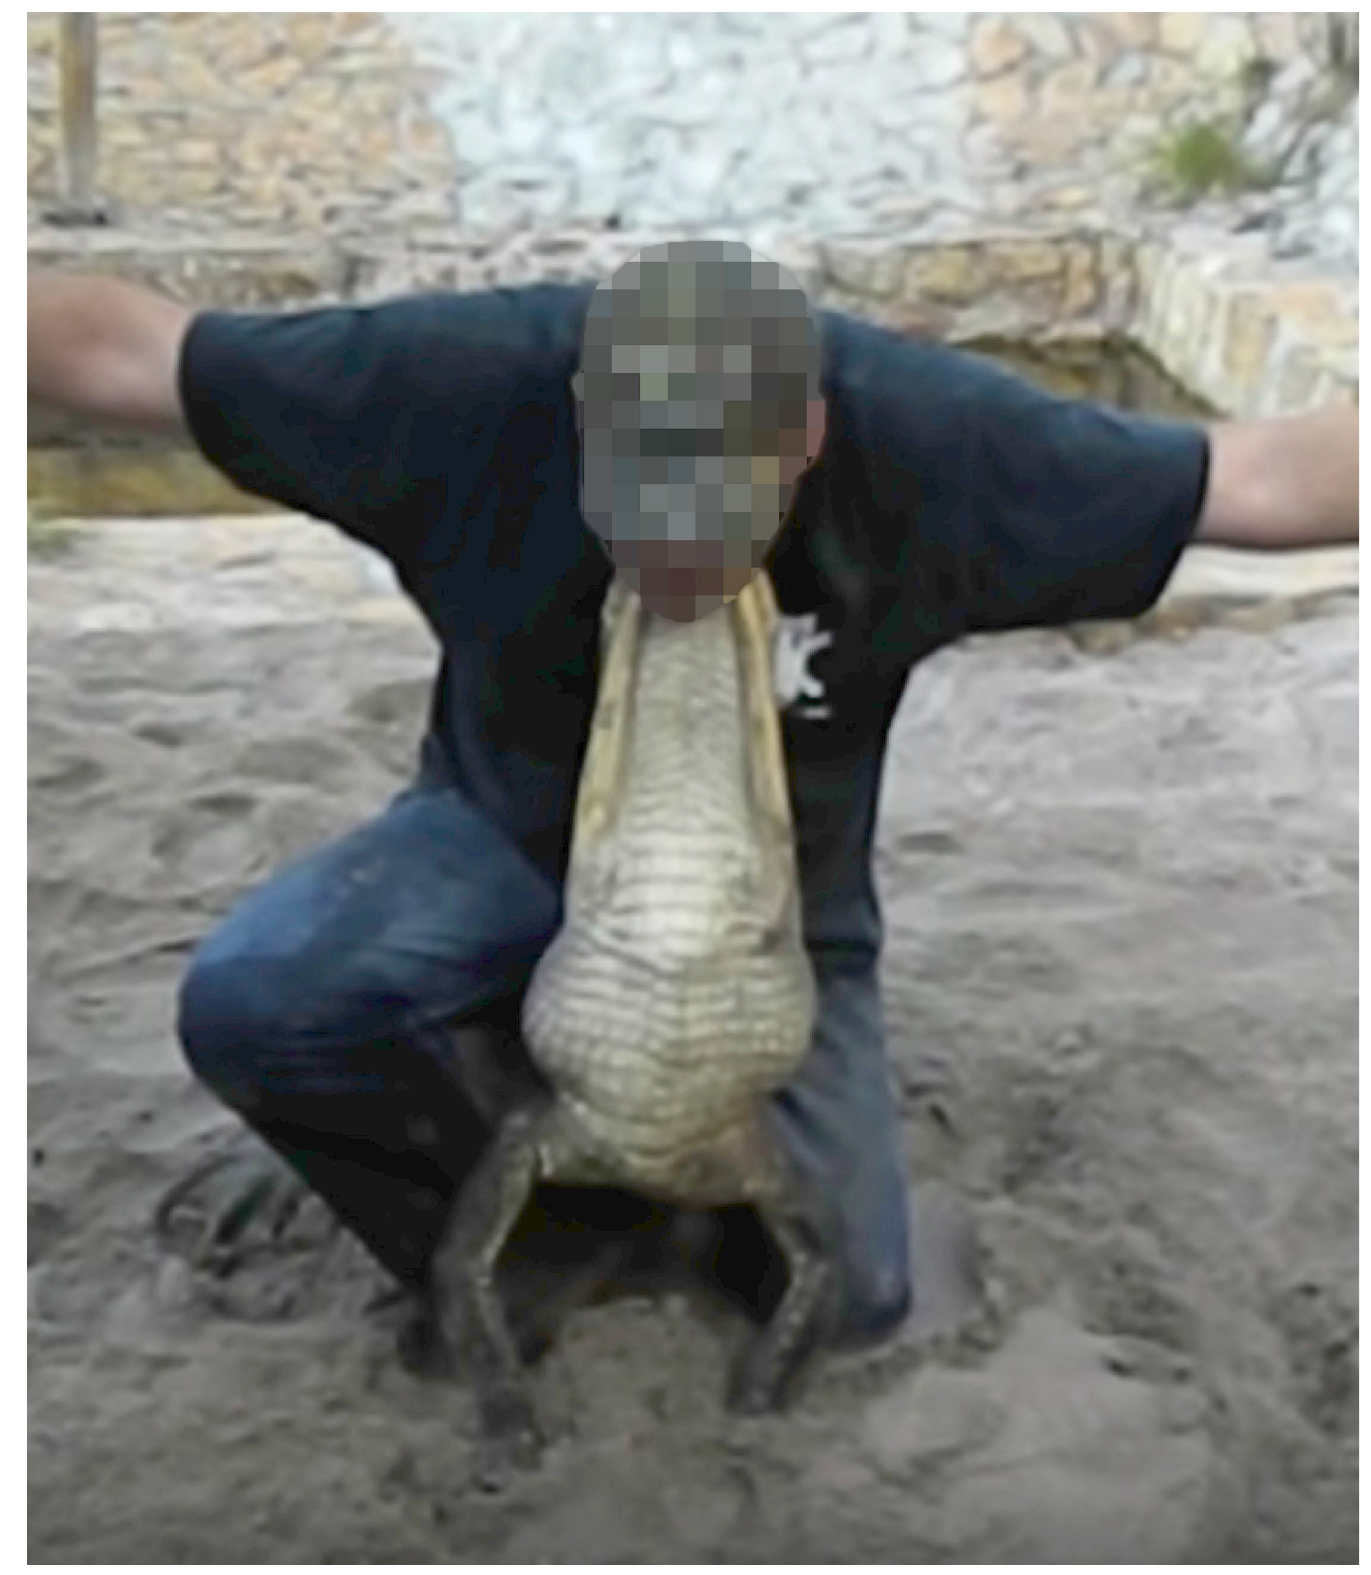
Fig 2. The “Bulldogging” stunt. Image captured from a video in the dataset.